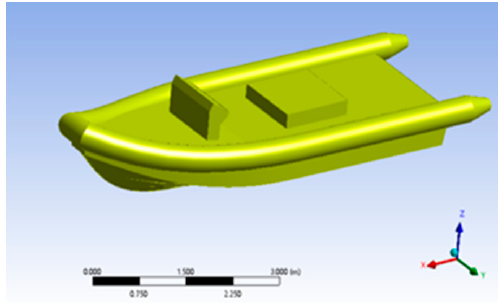
Figure 6. CAD model of the unmanned ship.